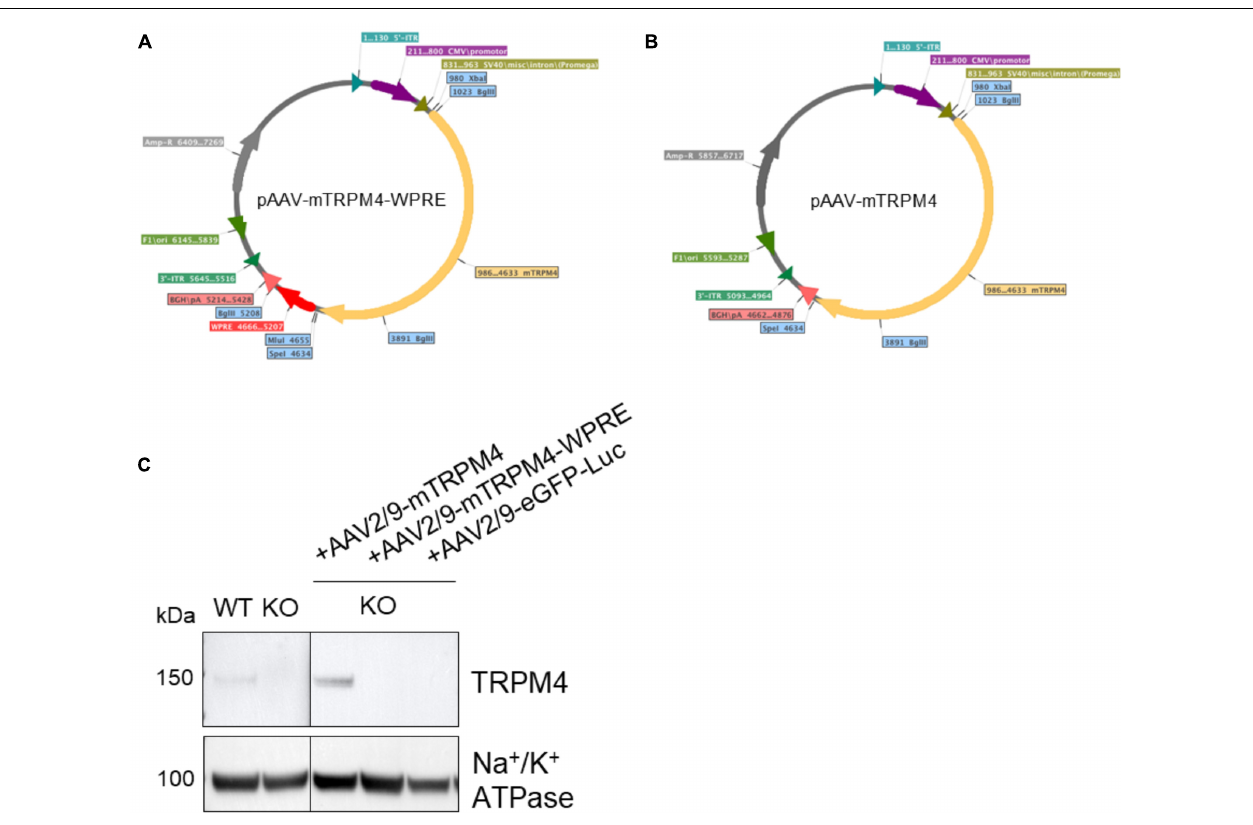
FIGURE 1 | Maps of plasmid constructs generated for this study. (A) cDNA of mouse TRPM4 was subcloned into XbaI and SpeI restriction sites resulting in a 5645 bp fragment between 5 (cid:48) -ITR and 3 (cid:48) -ITR. (B) After removal of WPRE, cDNA of mouse TRPM4 was subcloned into the same XbaI and SpeI restriction sites resulting in a shorter fragment of 5093 bp between 5 (cid:48) -ITR and 3 (cid:48) -ITR. (C) The two constructs were produced as viral particles and injected via tail vein into TRPM4 − / − mice to asses their functional expression. AAV2:9-eGFP-Luciferase was also included here. Each sample loaded (80 ug) was from membrane fraction